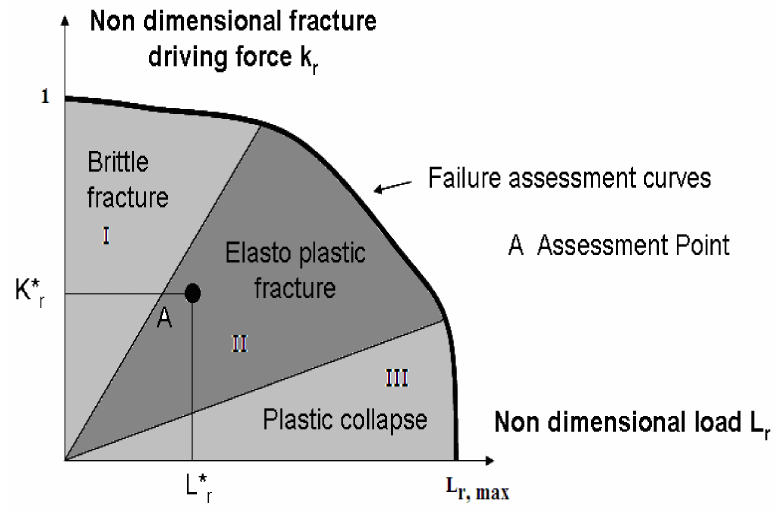
Figure 16. Domain failure assessment diagram.